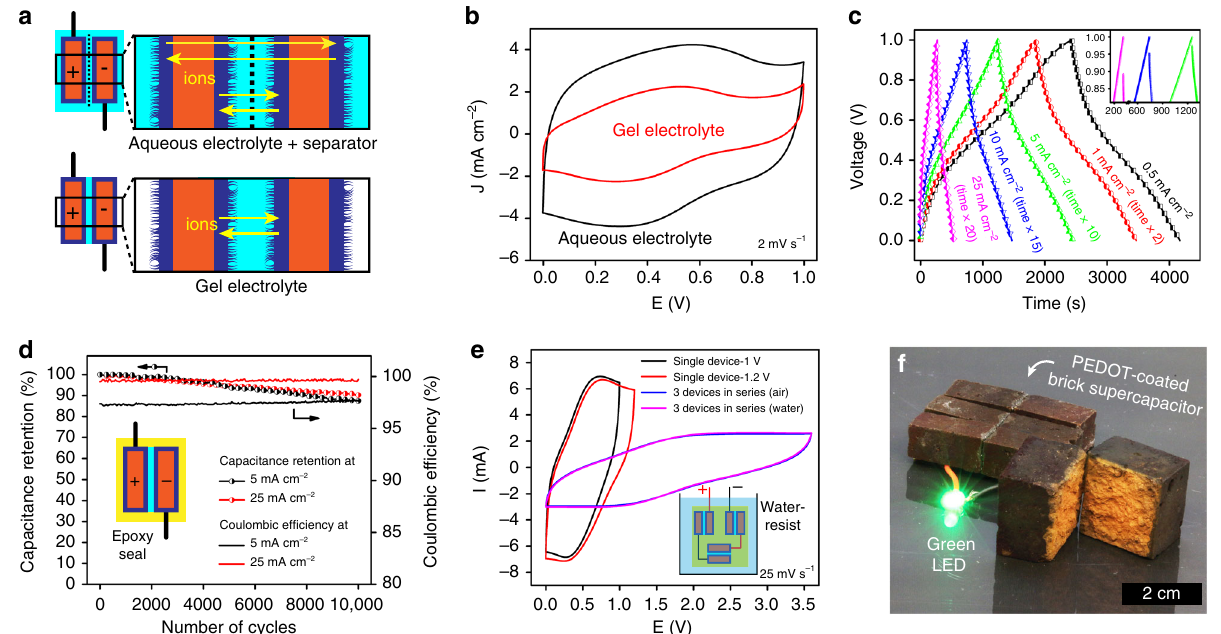
Fig. 5 Nano fi brillar PEDOT-coated bricks for supercapacitors. a Schematic illustration of aqueous electrolyte supercapacitor and quasi-solid-state supercapacitor shows different charge storage sites. The black dash line in the aqueous electrolyte device represents a separator. b Cyclic voltammograms for symmetric supercapacitors using 1 M H 2 SO 4 aqueous electrolyte and poly(vinyl alcohol)/H 2 SO 4 gel electrolyte. c Galvanostatic charge – discharge pro fi les for quasi-solid-state device at current densities ranging between 0.5 and 25 mA cm − 2 ; curves at 1, 5, 10, and 25 mA cm − 2 are horizontally expanded 2×, 10×, 15×, and 20×, respectively. Inset shows IR drop at current densities of 5, 10, and 25 mA cm − 2 . d Quasi-solid-state supercapacitor charge-discharge curves after 10,000 cycles at 5 and 25 mA cm − 2 exhibit 87% and 90% capacitance retention, respectively (coulombic ef fi ciency is ~100%). e Cyclic voltammograms for a single quasi-solid-state supercapacitor are collected at voltage windows of 1 and 1.2 V; a tandem device (comprised of three supercapacitors connected in series) withstands a 3.6 V window. The tandem device is waterproof after coated by epoxy and exhibits a